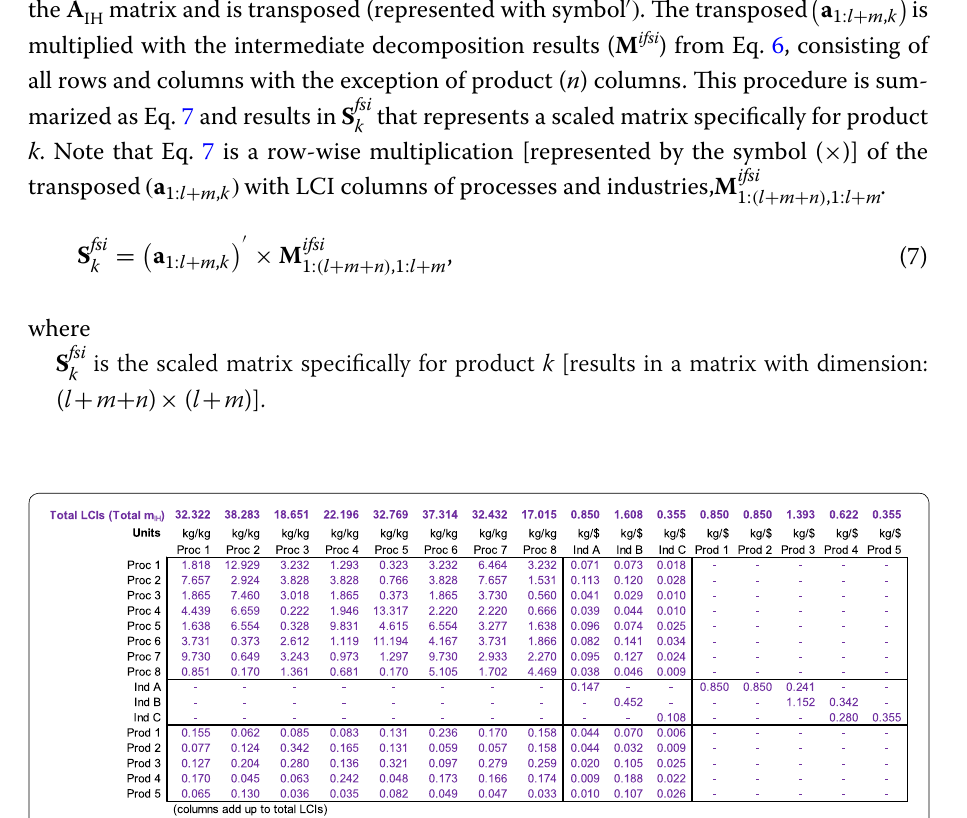
Fig. 6 Intermediate step in the decomposition of LCIs by final - stage inputs . Impacts from processes, products and industries are identified, but not yet allocated to